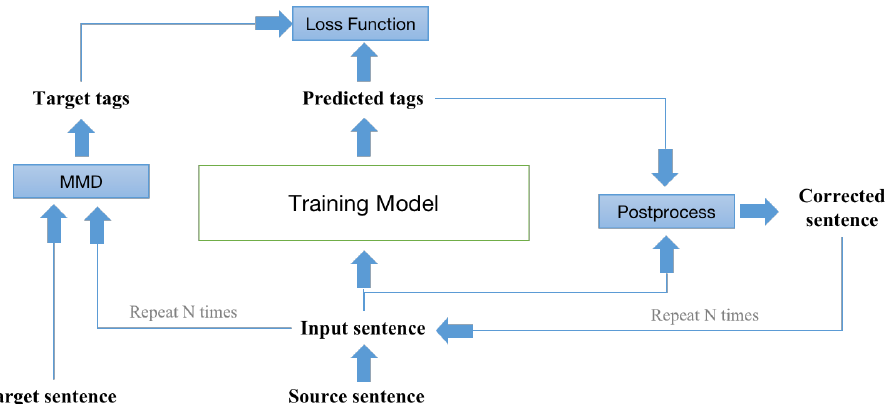
Figure 5. The structure of iterative